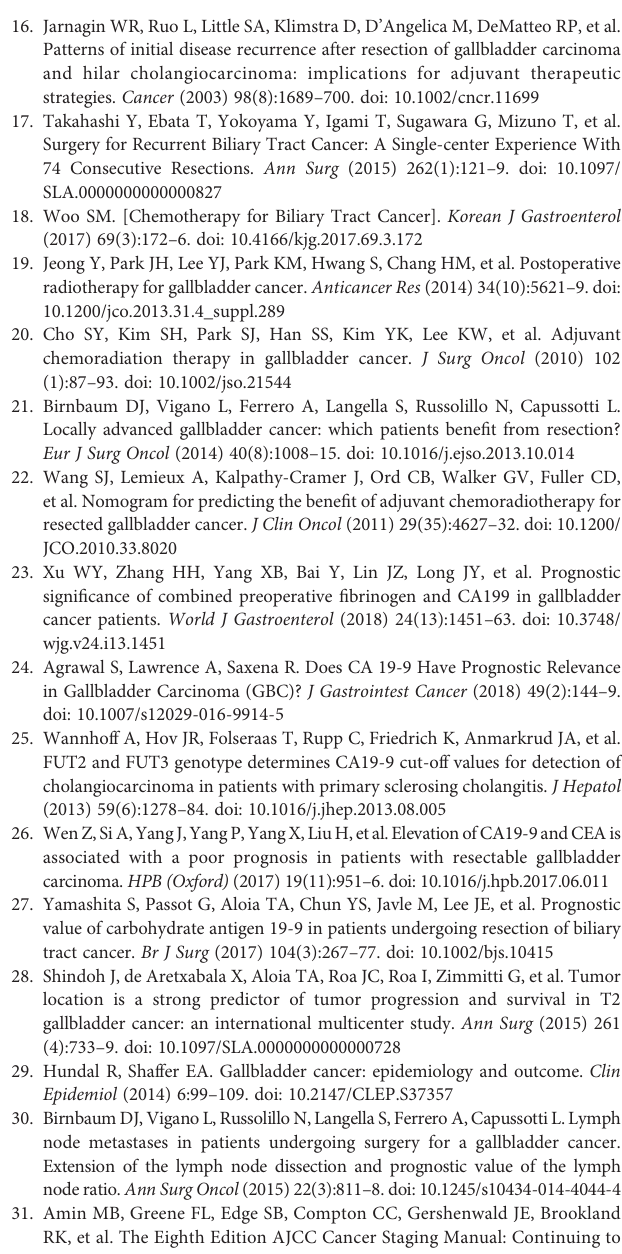
SUPPLEMENTARY TABLE 1 | Univariable analysis of post-recurrence survival in the training cohort. SUPPLEMENTARY TABLE 2 | Points assignment and risk